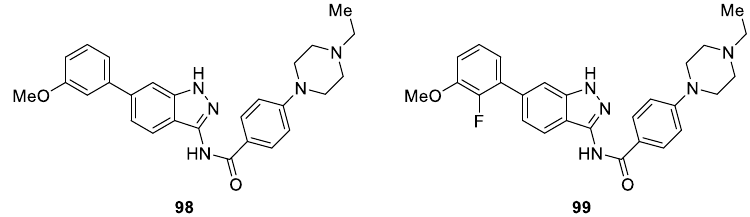
Figure 13. Chemical structures of 1 H -indazol-3-amine derivatives 98 and 99 .